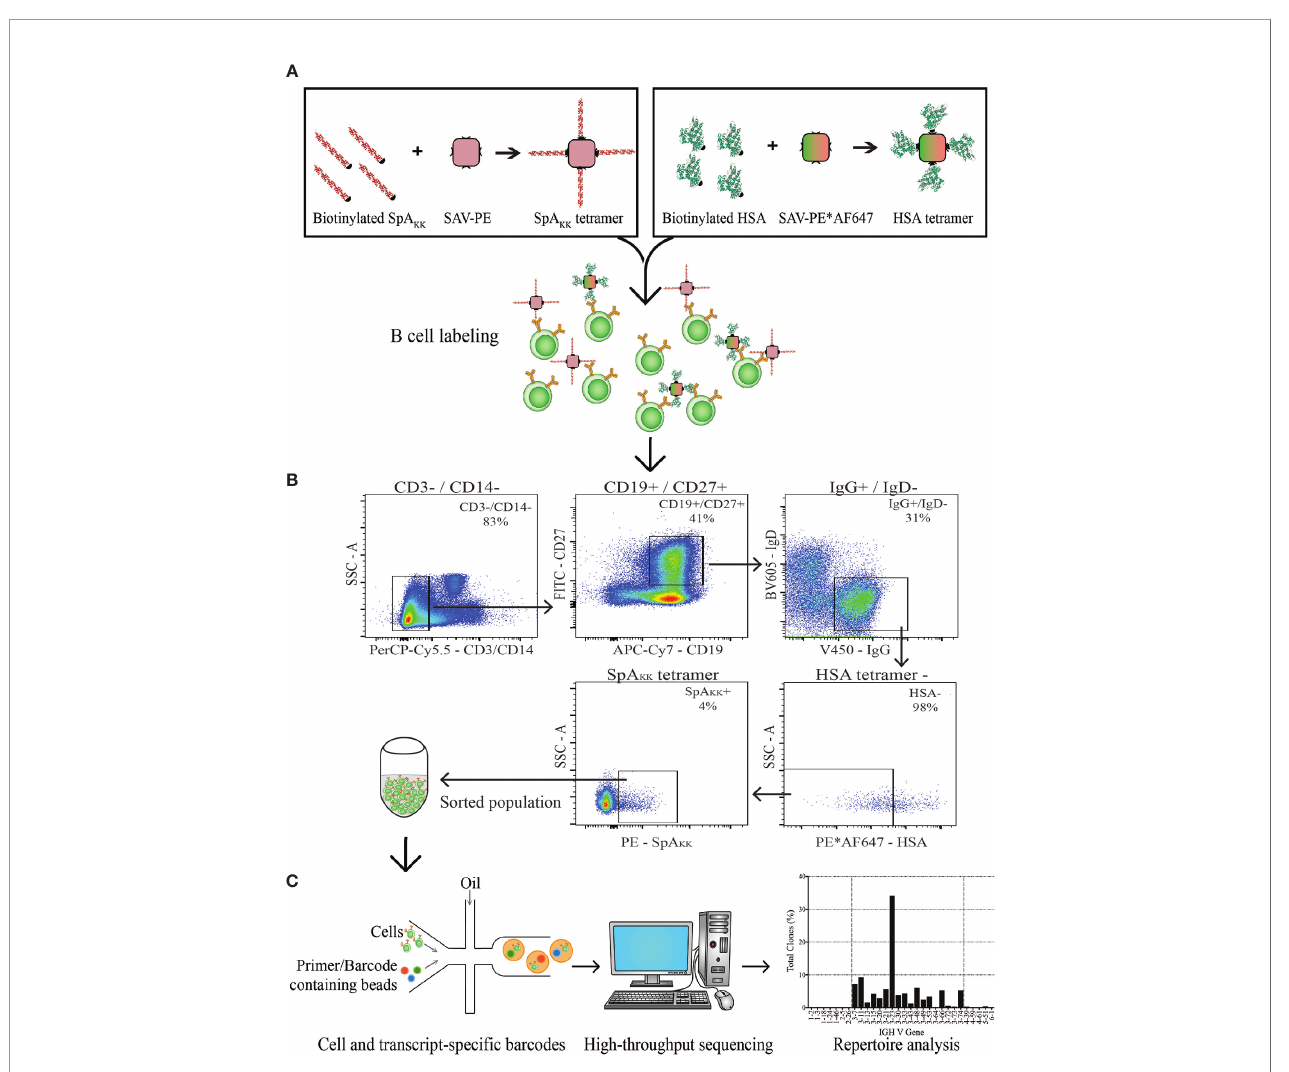
FIGURE 2 | Depiction of strategy for memory B cell sorting and BCR transcript sequencing. (A) PBMCs from a healthy donor were labeled with either SpA KK or control HSA-tetramers. (B) The memory B cell compartment positive for the SpA KK tetramer was identi fi ed and sorted. (C) The sorted population was collected, with single cell analysis that incorporates unique barcodes and high-throughput sequencing. Reads of BCR transcripts were analyzed for antibody gene usage and repertoire